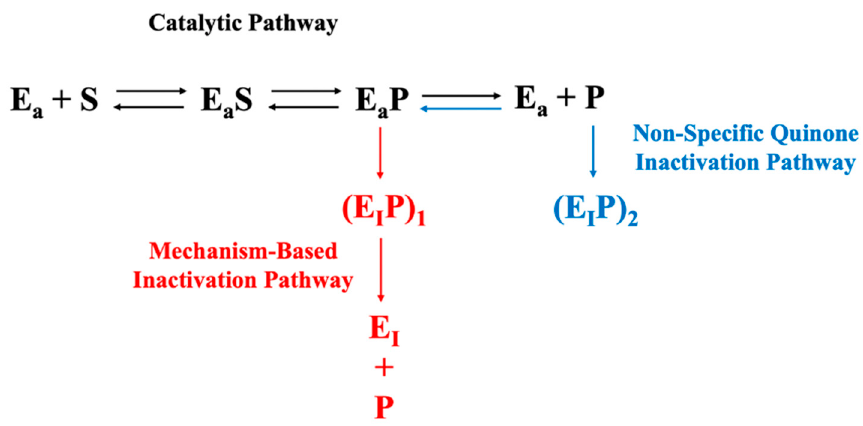
Figure 1. Mechanisms proposed to explain the inactivation of PPO. E a , active enzyme; S, suicide substrate; P, product (quinone); E a S, active enzyme-substrate complex; E a P, active enzyme-product complex; (E I P) 1 and (E I P) 2 , inactive enzyme-product complexes 1 and 2, respectively; E I , inactive enzyme.